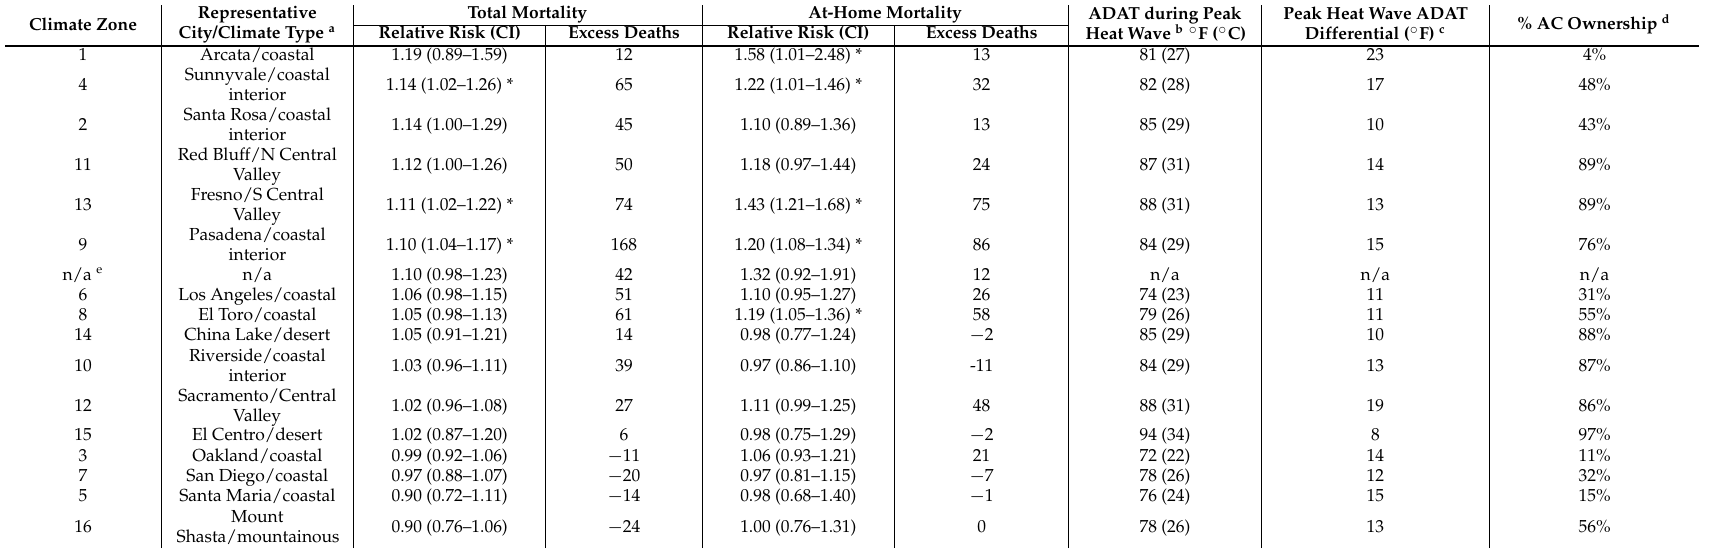
Table 3. Climate zone characteristics, heat wave mortality relative risks and excess deaths for all deaths and deaths that occurred at-home, temperature during the heat wave, and AC